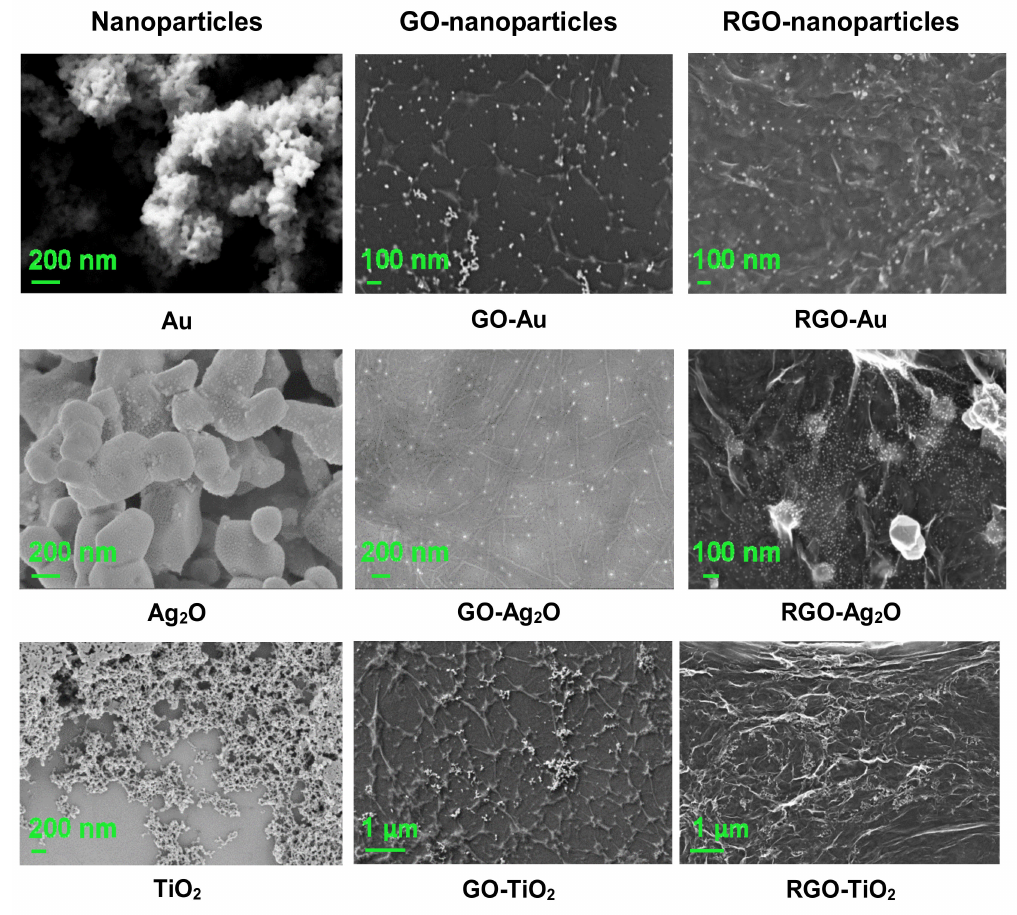
Figure 10. SEM images of nano-Au, nano-Ag 2 O, and nano-TiO 2 particles and their composites with GO and RGO. Di ff erent magnifications were used to best present the morphology of each